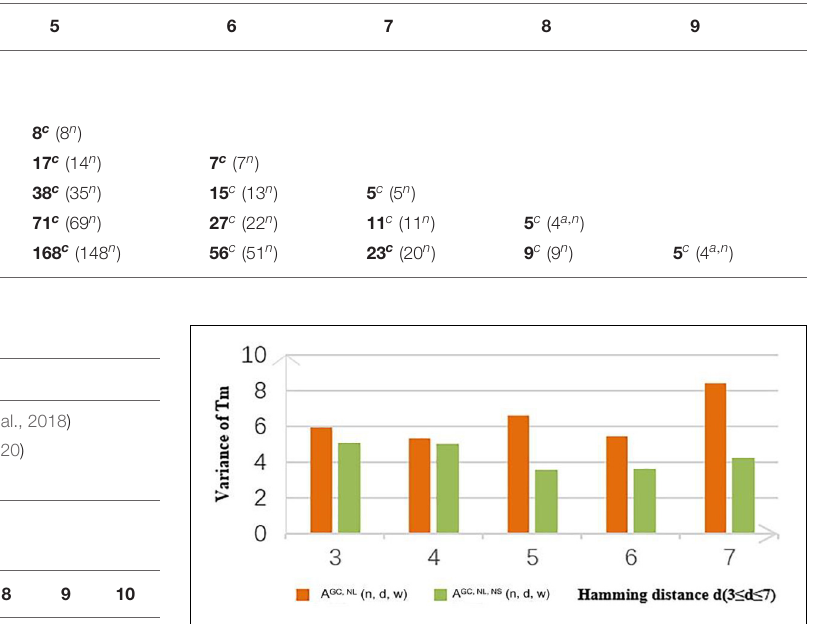
FIGURE 5 | Tm difference of A GC , NL ( n , d , and w ) and A GC , NL , NS ( n , d , and w ) with n =